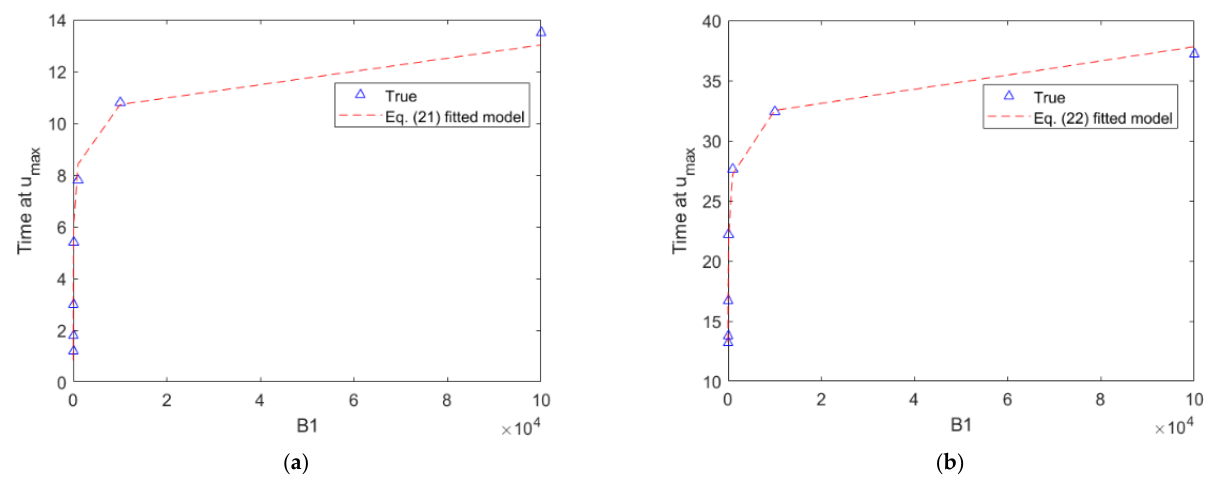
Figure 14. The t max time against parameters B 1 for the application of Policy 2 versus the fitted model of Figure 14. The max t time against parameters 1 B for the application of Policy 2 versus the fitted model of Equations (21) Equations (21) and (22). ( a ) Control effort u 1 ; ( b ) Control effort u 2 and (22). ( a ) Control effort 1 u ; ( b ) Control effort 2 u .